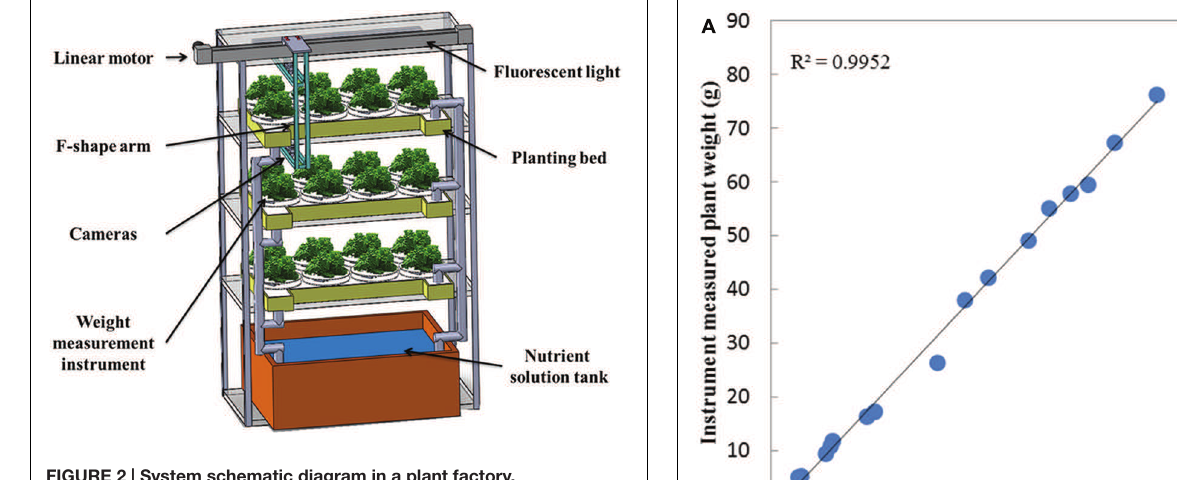
FIGURE 2 | System schematic diagram in a plant factory.